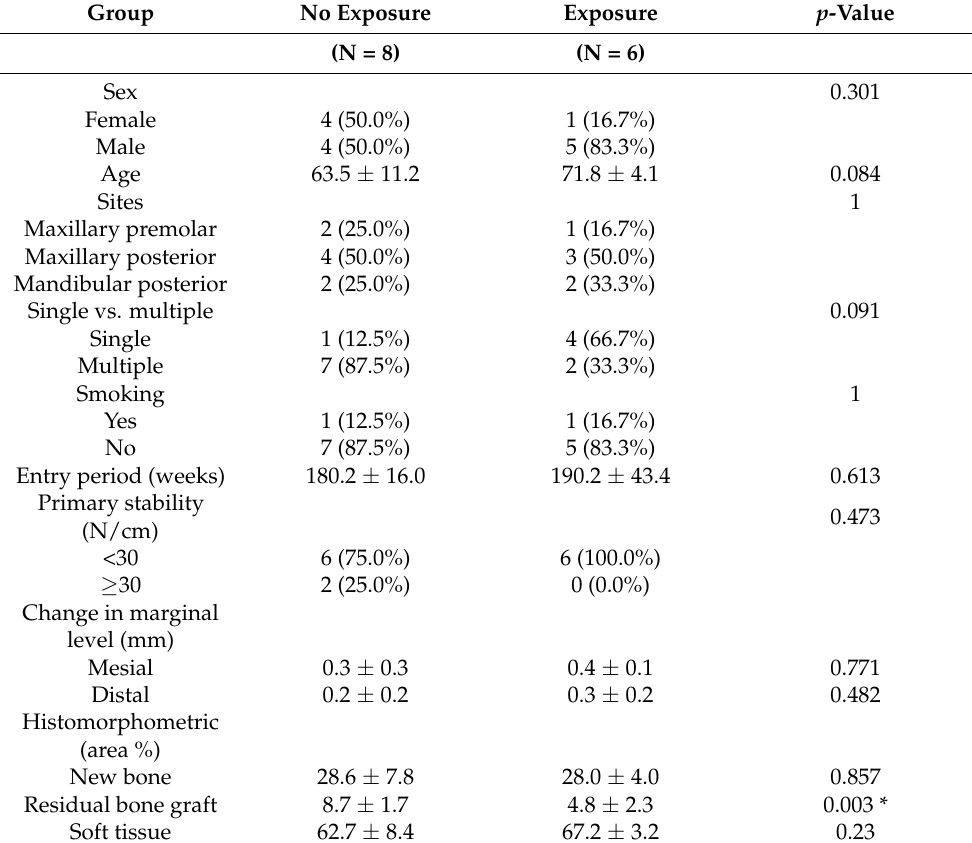
Table 2. Baseline characteristics and outcomes in exposed and nonexposed